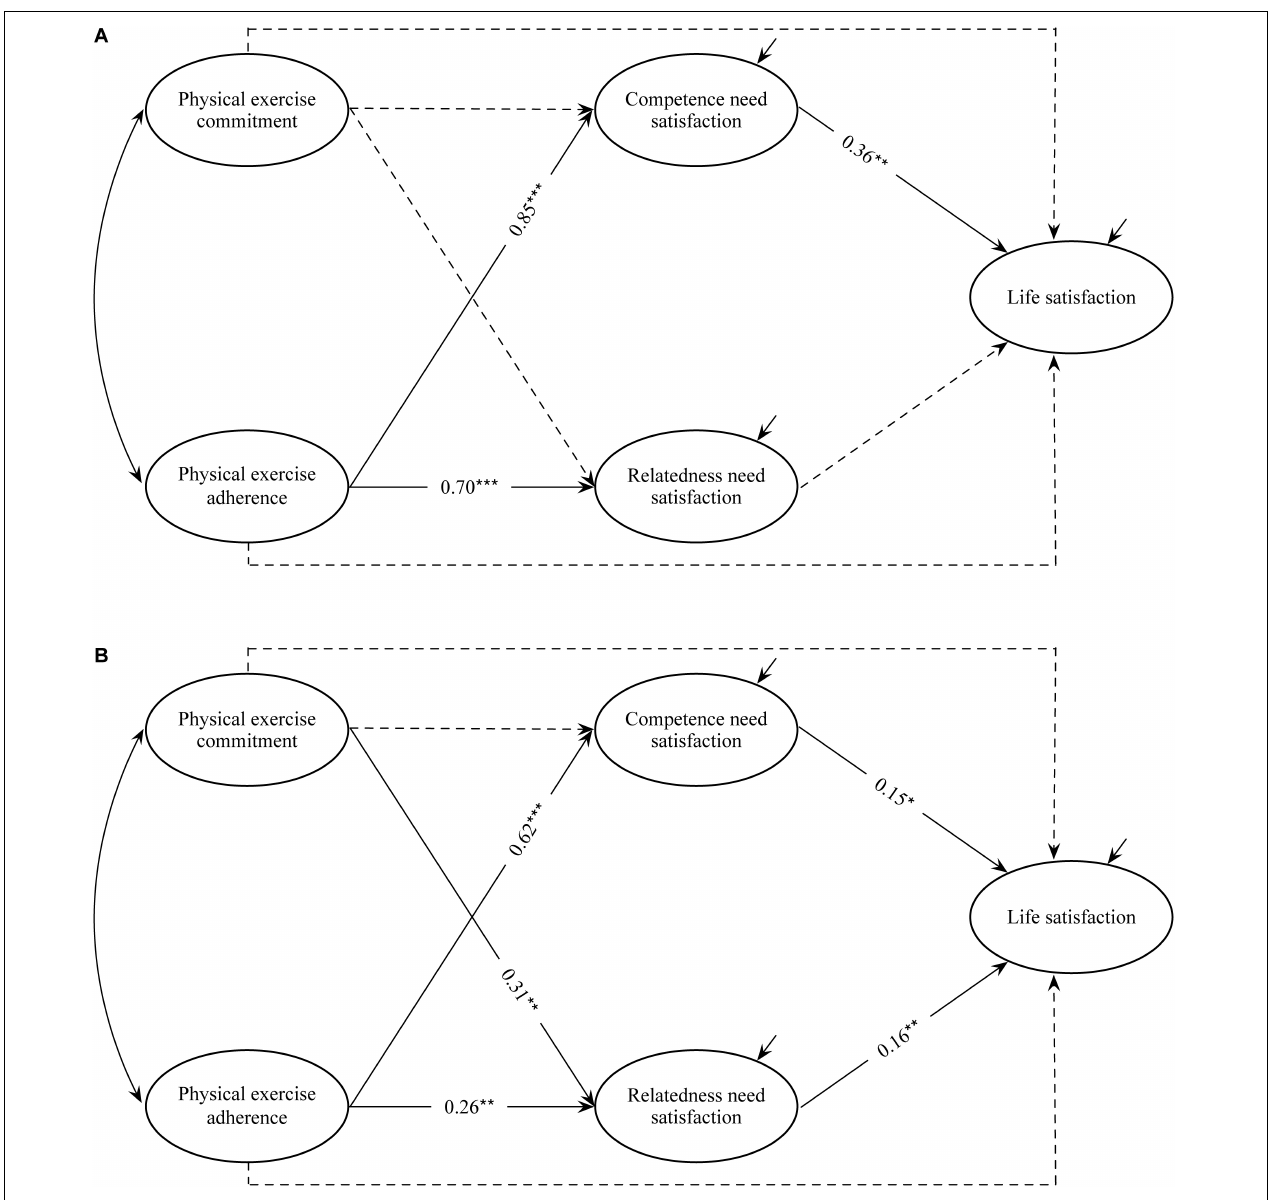
FIGURE 2 | Multi-group mediation model from physical exercise to life satisfaction. * p < 0.05, ** p < 0.01, *** p < 0.001; Dashed lines indicate non-significant coefficient. (A) Physical education major. (B) Nonphysical education